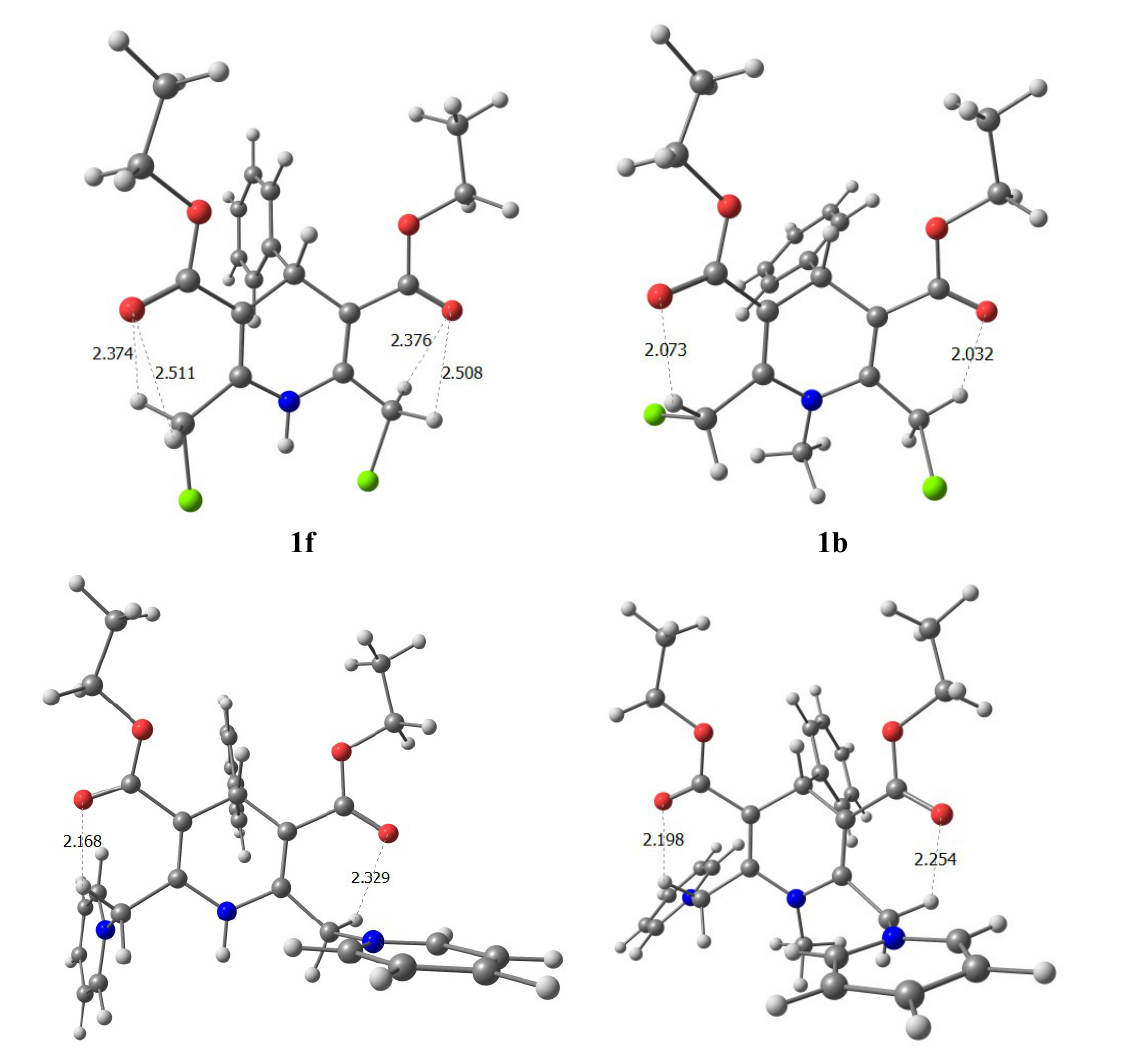
Figure 1. The calculated optimal conformations in compounds 1f , 1b and 2f , 2b